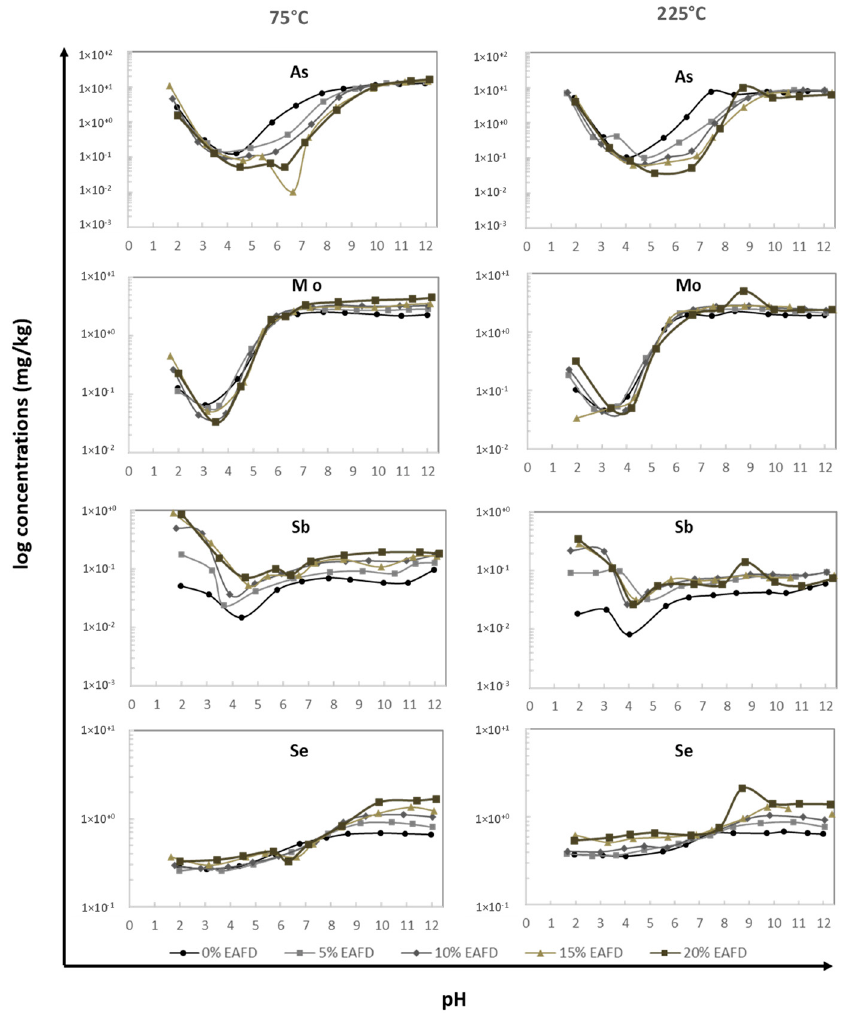
Figure 5. Concentrations (mg/kg) of As, Sb, Mo, and Se in the leachate after the pH dependence test of the geopolymers with EAFD at 75 °C and 225 °C.